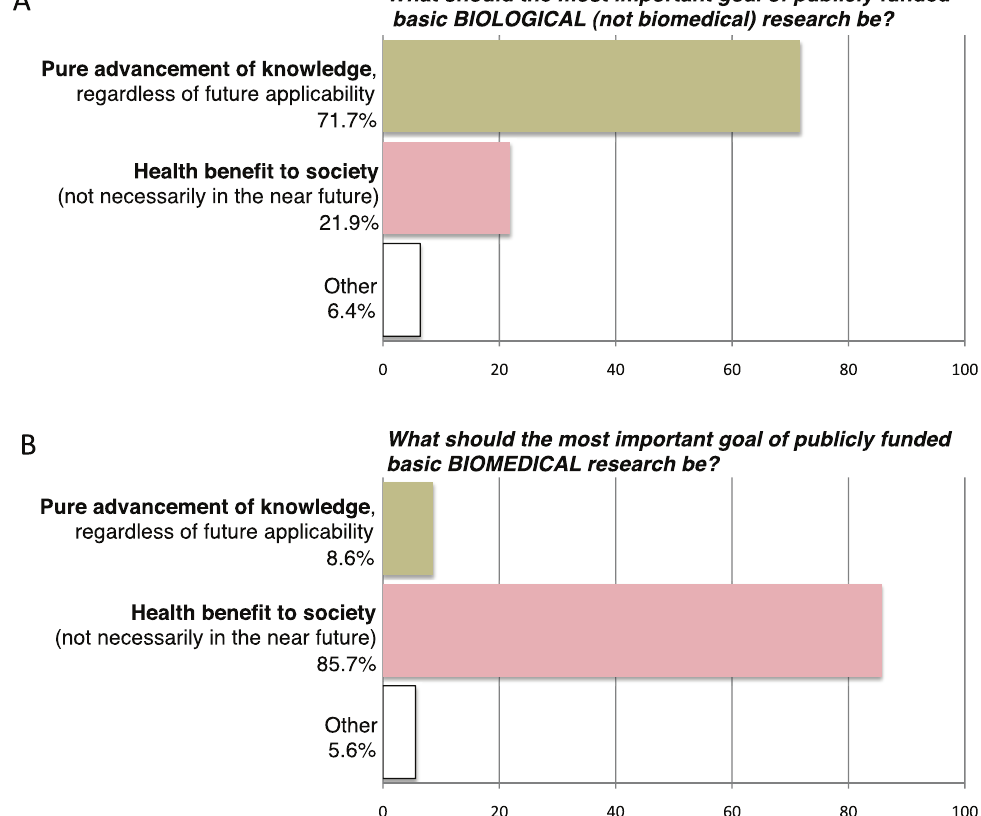
Figure 2. What is the main goal of biological and biomedical research? ( A ) Graph shows how scientists answered the following question: “What should the most important goal of publicly funded basic BIOLOGICAL (not biomedical) research be?”. Surveyed scientists were given the indicated three choices. 297 answered the question; 7 skipped. ( B ) Graph shows how scientists answered the following question: “What should the most important goal of publicly funded basic BIOMEDICAL research be?” Surveyed scientists were given the indicated three choices. 301 answered question; 3